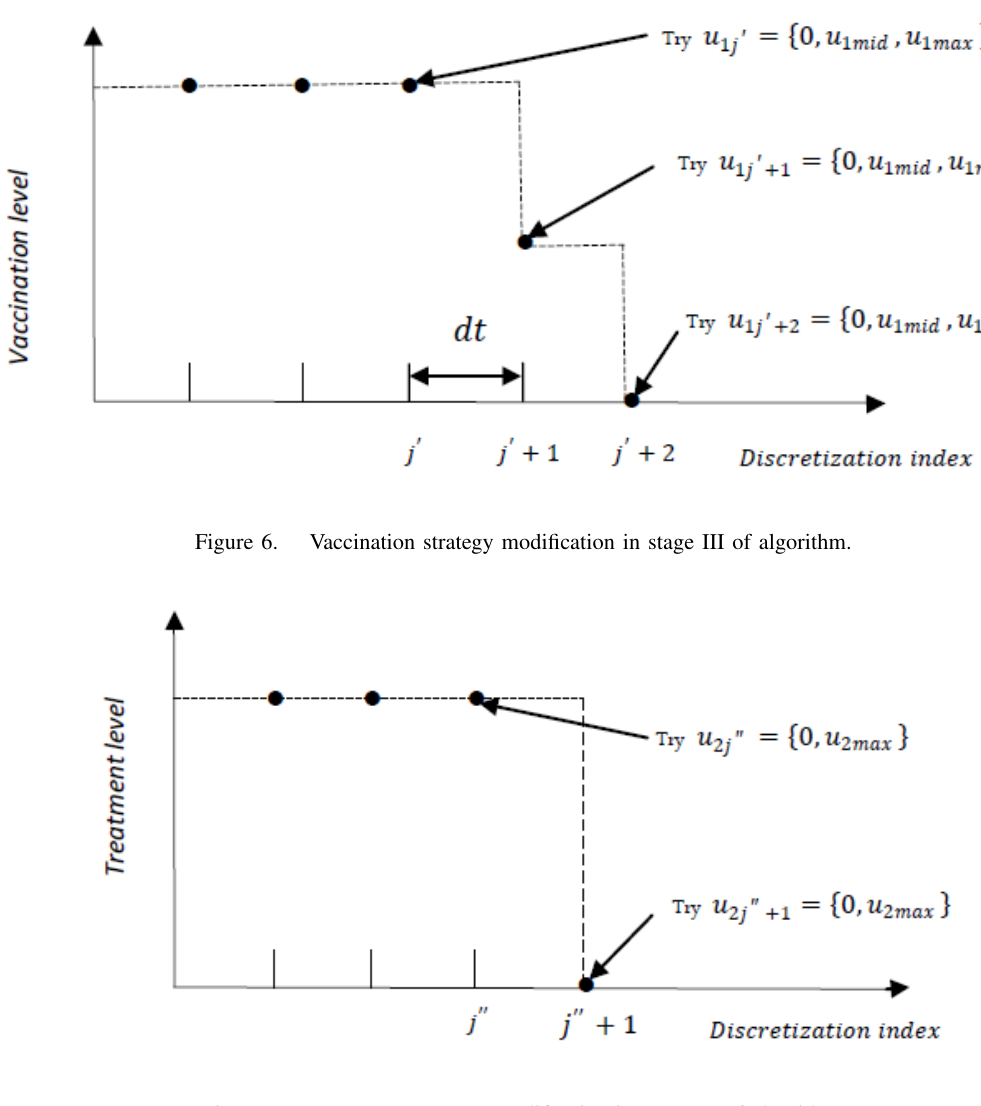
Figure 7. Treatment strategy modification in stage III of